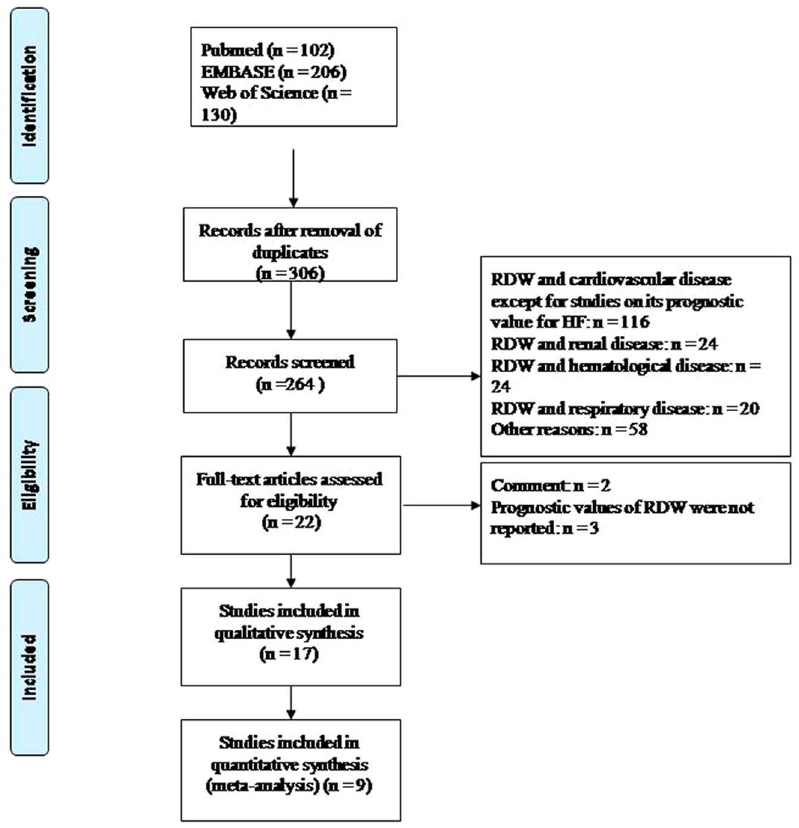
Figure 1. Flow chart for study identification and inclusion.